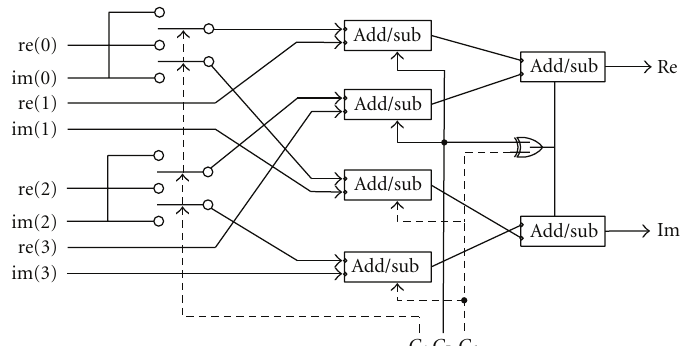
Figure 2: R4SDC butterfly element of stage t .